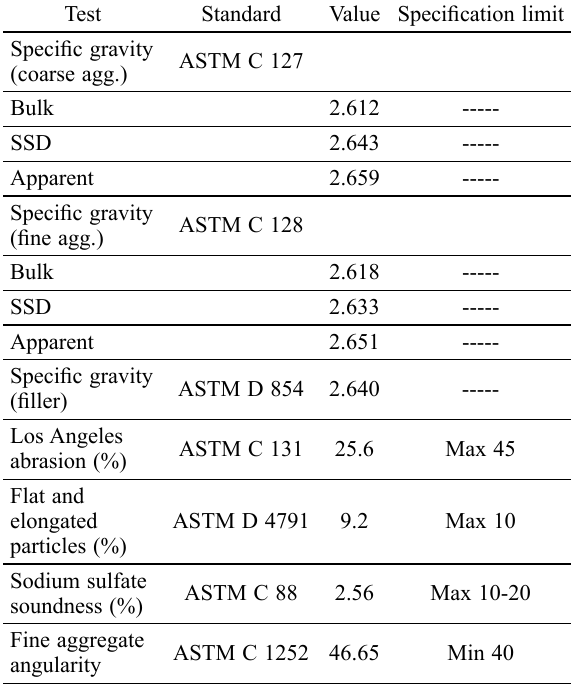
Table 1. Physical properties of the aggregates